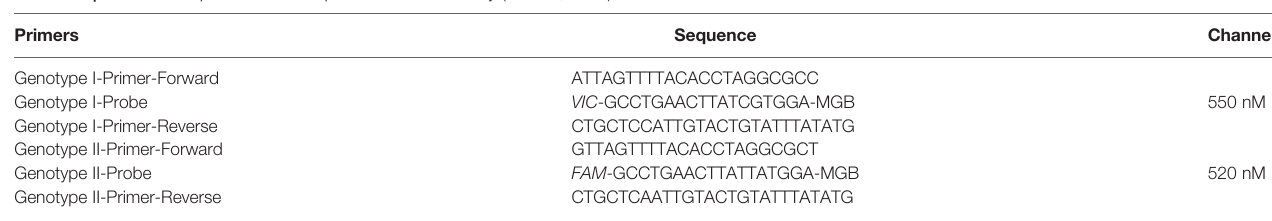
TABLE 1 | Primers and probes of the duplex iiPCR in this study (Li et al., 2022). Primers Sequence